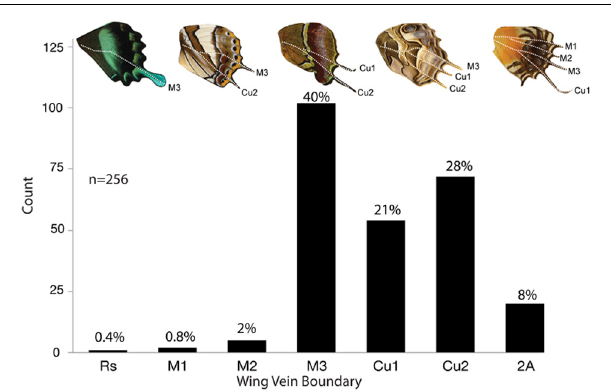
FIGURE 10 | Frequency of tails across five butterfly families. A total of 161 genera across 5 families were observed to have tails. Some genera had multiple tails and were counted more than once for a total of 256 observations. Tails emerge most frequently at M3 (40%), followed by Cu2 (28%), and Cu1 (21%).